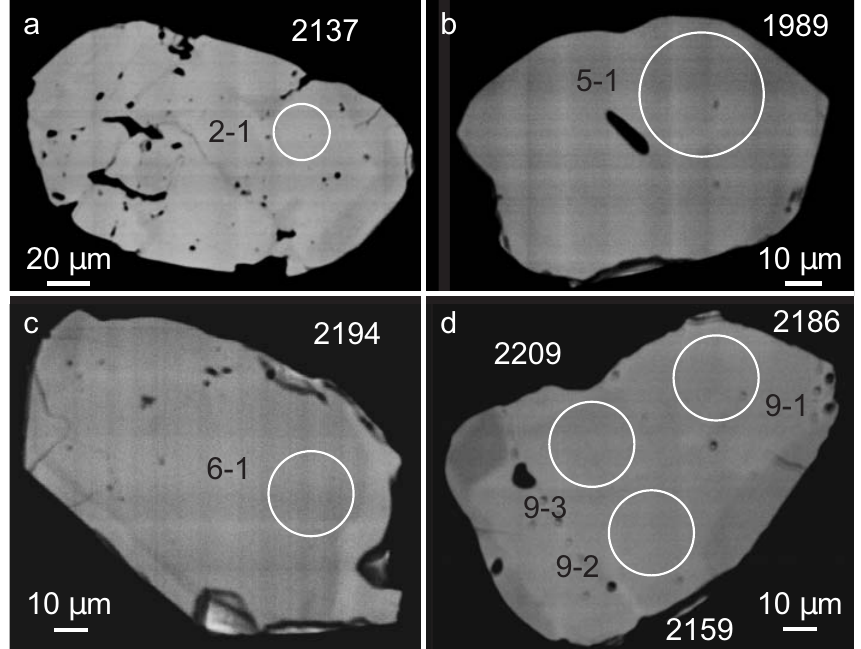
Fig. 5 – Backscattered electron images of zircon crystals from the studied sample. White circles indicate position of SHRIMP isotopic analyses; spots number and ages (Ma) indicated.